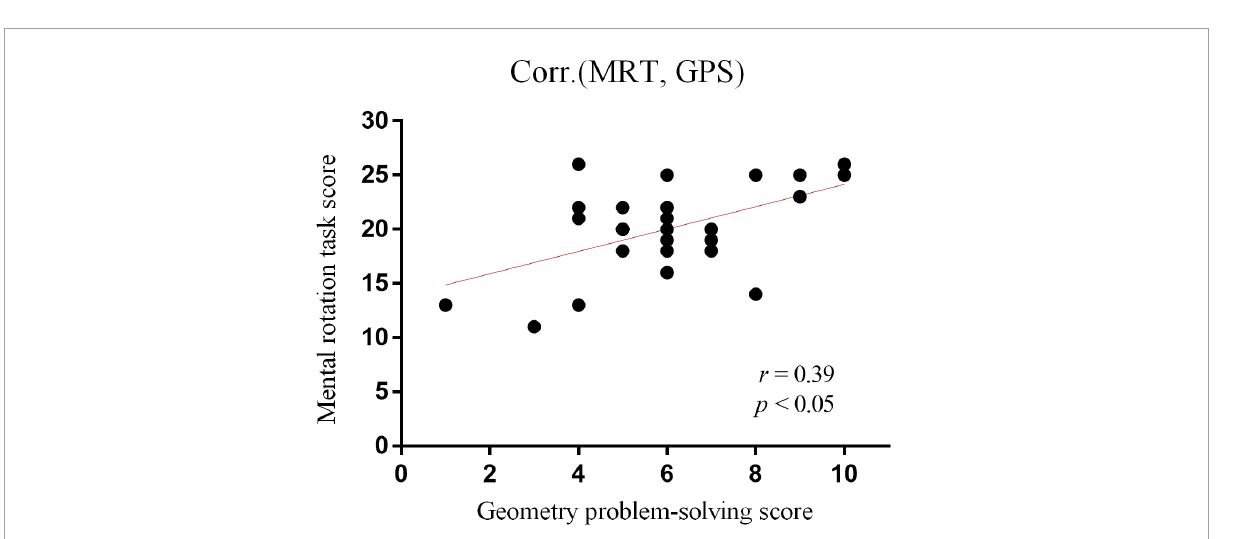
FIGURE4 Scatter plot between the number of correct responses on MRT and geometry problem-solving test (scores).